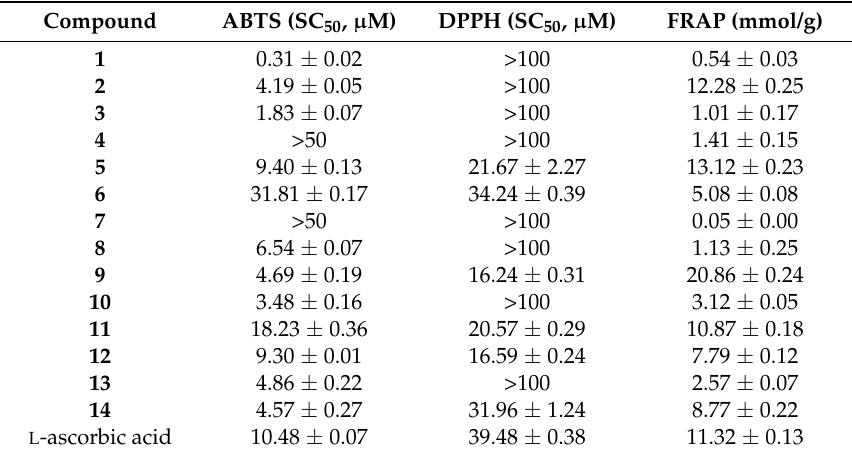
Table 2. Antioxidant activity of compounds 1 – 14